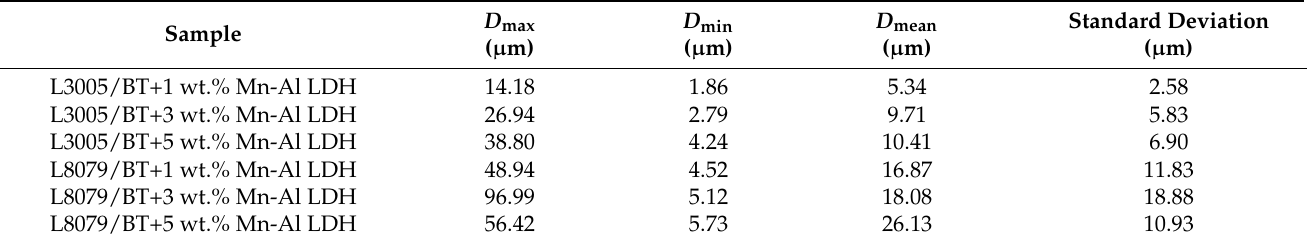
Table 4. The size distribution of Mn-Al LDH aggregates after the contact with Al substrate.